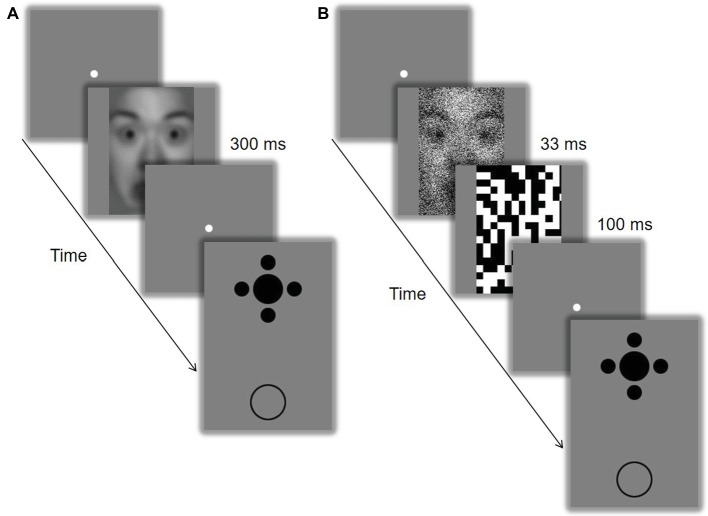
Schematic representation of the experimental procedures. In Experiment 1 (A), the filtered face was presented for 300 ms, followed by the Ebbinghaus configuration. In Experiment 2 (B), the filtered face was presented for 33 ms followed by a black-and-white random-noise mask. The identifiable image is model #18 from the NimStim Set of Facial Expressions (Tottenham et al., 2009) and is released for publication in scientific journals.